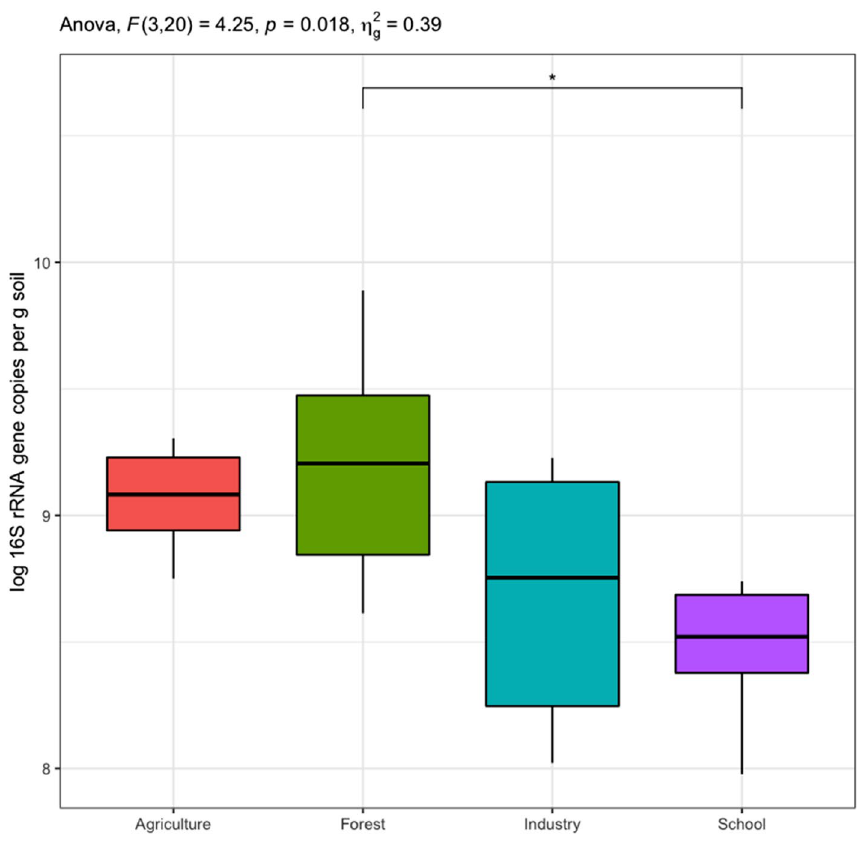
Figure 2. Log transformed 16S rRNA gene copy numbers per g of soil in samples derived from agricultural, industrial, forested and schoolyard areas. Spreads in the boxplots denote standard error of the mean and asterisks show statistically significant differences between treatments (* p < 0.05